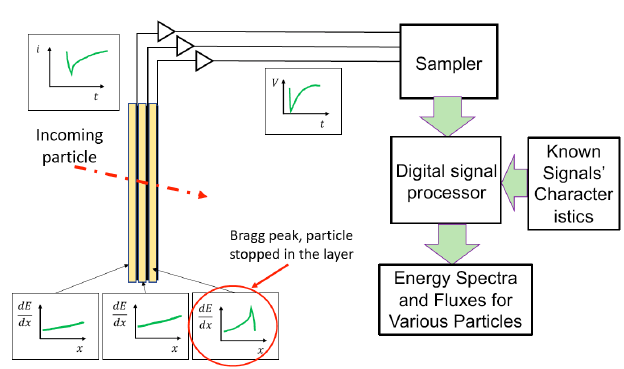
Fig. 3. Schematic of the simulation of the events measured by AGILE. We first use te signal collected by three layers of the fast Silicon detector. We use a fast sampling method to sample that signal, which is then digitized. It leads to a database of energy spectra and fluxes for different particles that allow to define the best characteristics for particle identification and energy measurement.